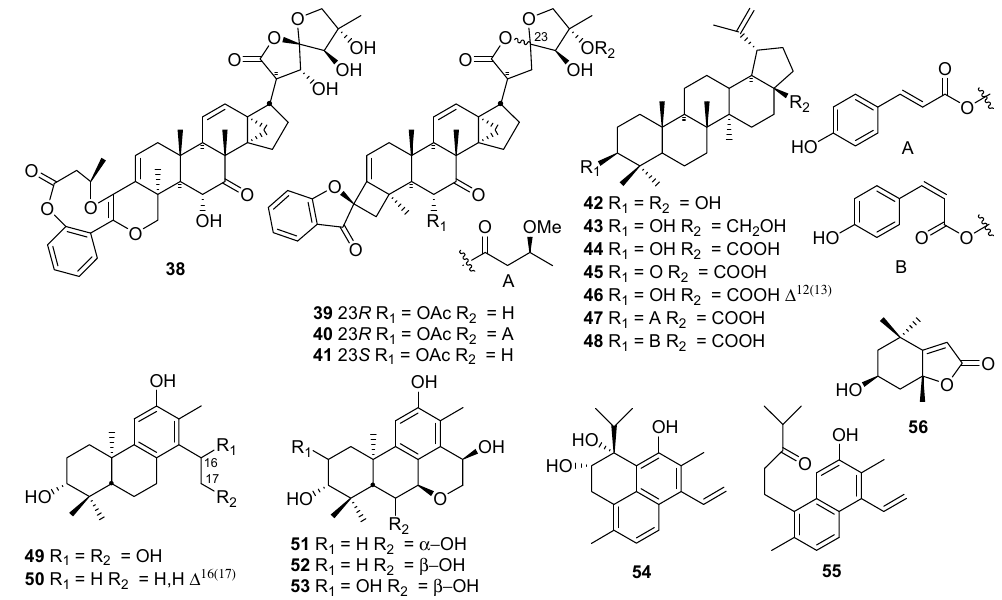
Figure 2. Terpenoids from various Phyllanthus species. Figure 3. Phenolic compounds from various Phyllanthus species. Table 2. Structures and sources of terpenoids from various Phyllanthus species.